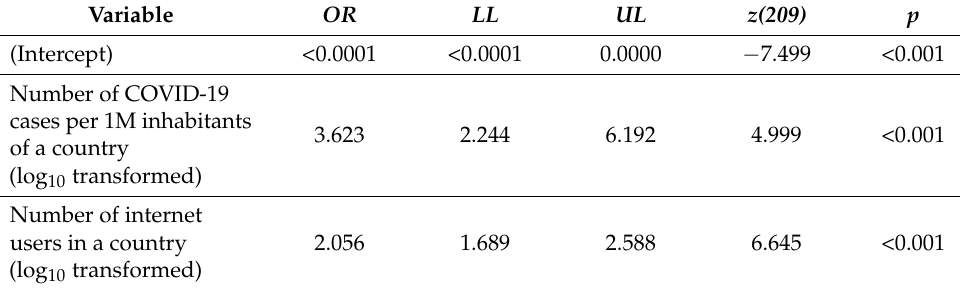
Table 4. Results of the GLM testing the association between the occurrence of interest in coronavirus memes (Google Trends index) and total number of COVID-19 cases per one million inhabitants and percentage of internet users in different countries. Odds ratio (OR) with 95% confidence intervals (LL–lower confidence intervals, UL–upper confidence intervals) and Wald z–test (with residual degree of freedom). Model explained 37% variation in data (McFadden pseudo- R 2